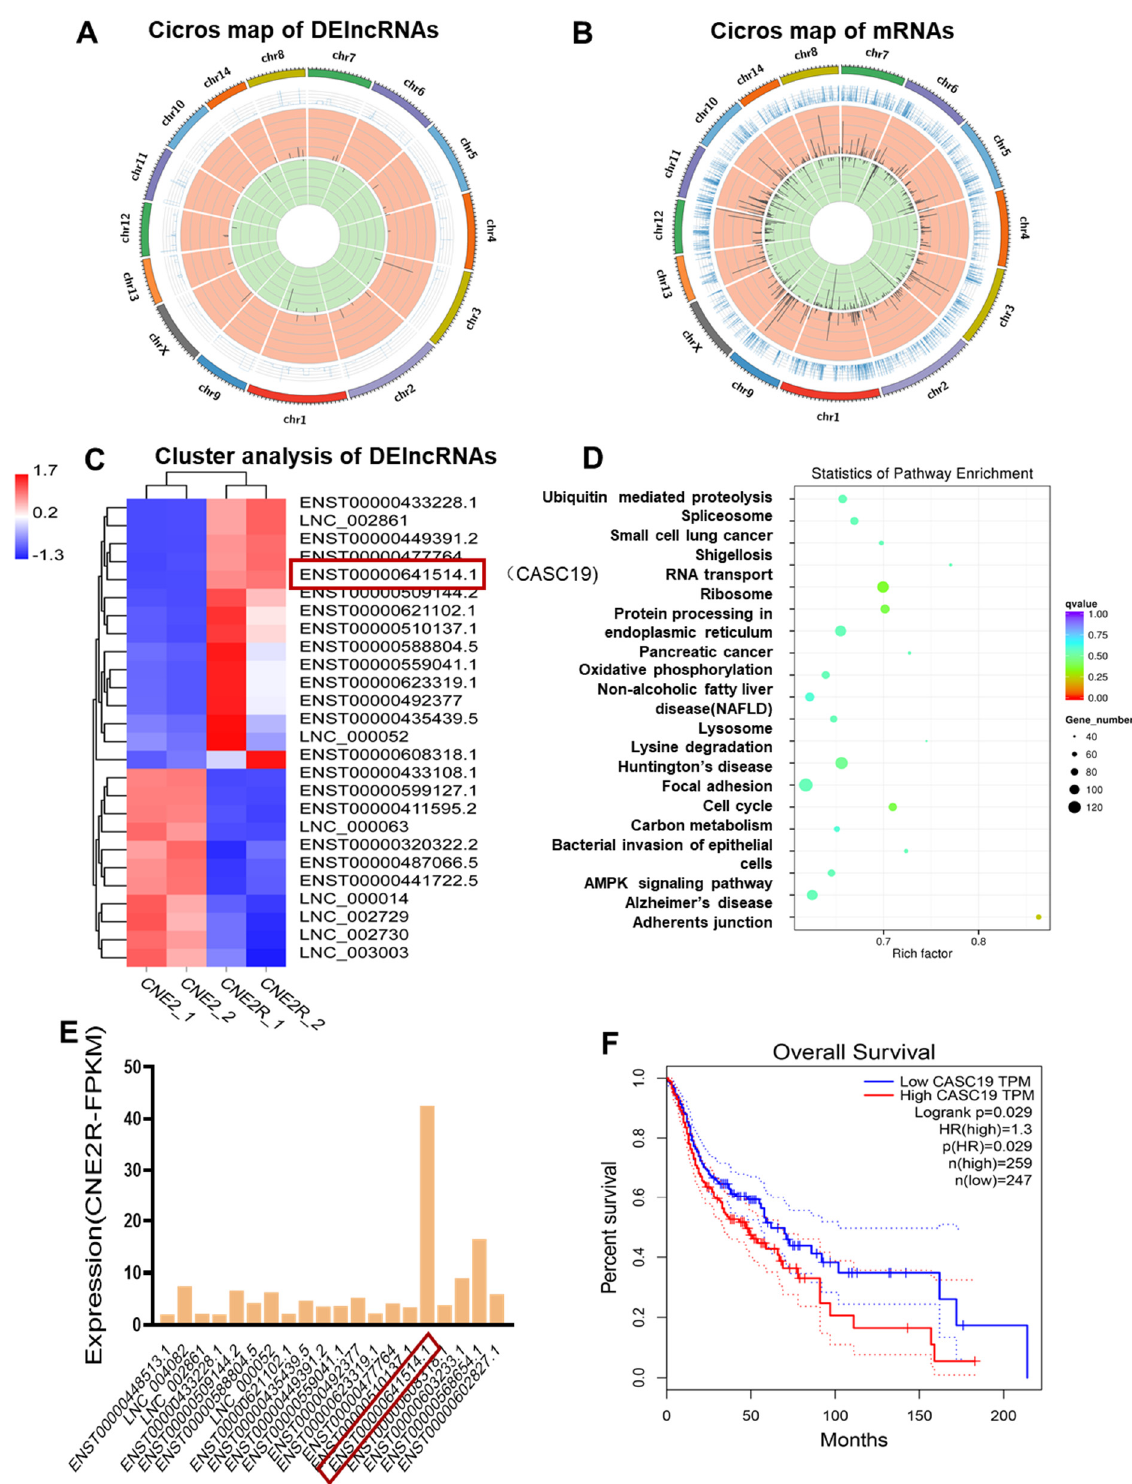
Figure 2. RNA-seq analysis of the paired radiosensitive and radioresistant nasopharyngeal carcinoma (NPC) cell lines CNE2 and CNE2R. ( A , B ) The Circos plots of total DElncRNAs and DEmRNAs between CNE2 and CNE2R cells. ( C ) The heat map plot of the distinguishable DElncRNAs with the threshold of log2 (fold changes) > 1.5 ( p < 0.05). ( D ) KEGG pathway analysis of the DElncRNAs co-expressed mRNAs with a correlation coefficient larger than 0.995 ( p < 0.05). ( E ) The expression abundance (FPKM, FragmentsPer Kilobase per Million) of the top 20 upregulated DElncRNAs in radioresistant cell line CNE2R. ( F ) Kaplan–Meier analysis of the relationship between the expression of CASC19 in head and neck squamous cell carcinoma (HNSC) and overall survival (OS) of the patients (data from GEPIA).